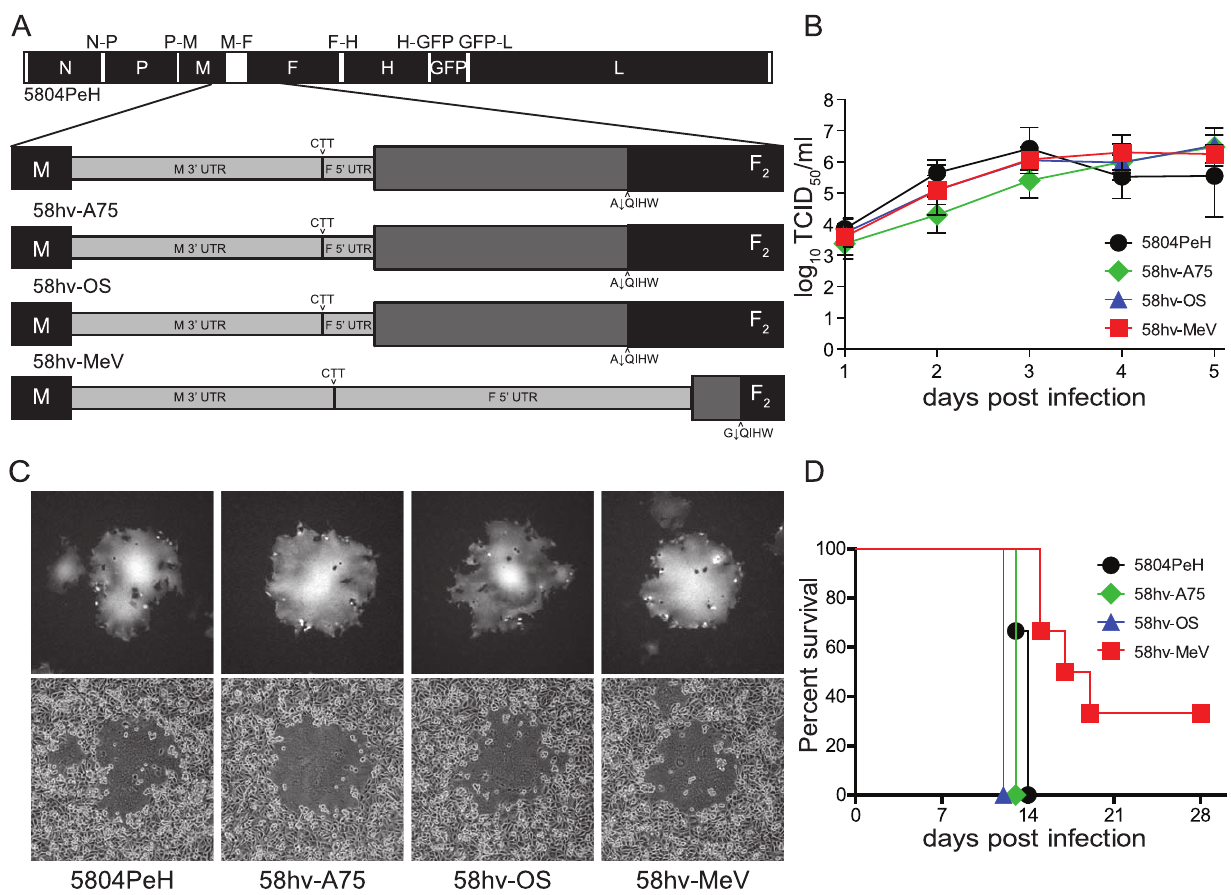
Figure 1. Growth characterization of recombinant M-F region exchange mutants. ( A ) Schematic drawing of the highly variable region exchanged in recombinant viruses. The recombinant 5804PeH genome is drawn to scale. Black and white boxes represent open reading frames and UTRs, respectively. The genes are indicated by their respective abbreviation. ( B ) Cell-associated growth curves of the parental and two recombinant viruses in VerodogSLAMtag cells. Cells were infected with a multiplicity of infection (MOI) of 0.01, and samples were harvested daily for five days. Titers are expressed as 50% tissue culture infectious doses (TCID 50 ). Error bars indicate the standard deviation. ( C ) Syncytia formation in VerodogSLAMtag cells. Cells were infected with a MOI of 0.01 and overlaid with 0.5% methylcellulose. Photographs show a representative syncytia of one replicate taken 48 h post-infection using fluorescence excitation (top panels) and phase contrast (bottom panels) at 100 6 magnification. ( D ) Survival curve of ferrets infected with the different mutants. Animals were infected with 10 5 TCID 50 intranasally. Death of an infected animal is indicated by a step down on the graph.